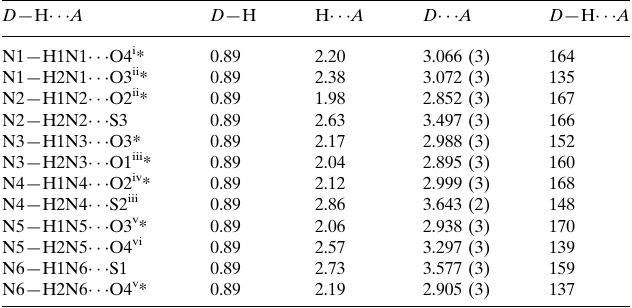
Hydrogen-bond geometry (A˚ , (cid:3)